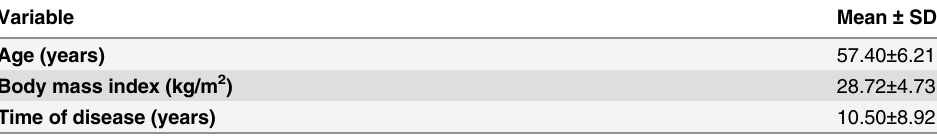
Table 1. Sample demographic and anthropometric